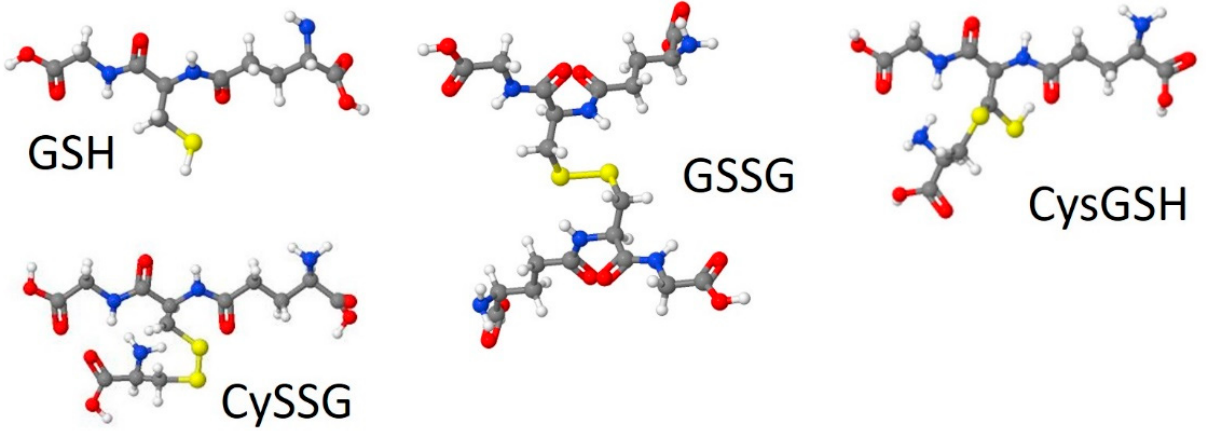
Figure 1. Structures of glutathione (GSH), L-cysteine-glutathione disulfide (CySSG), glutathione disulfide (oxidized glutathione, GSSG), and cysteinyl glutathione (CysGSH). Models were drawn by Jmol, through an interface on Wikipedia (GSSG) or at http://biomodel.uah.es/en/DIY/JSME/draw.en.htm (GSH, CySSG, and CysGSH; accessed 10 and 11 August 2021), based on CID structures 124886 for GSH, 10455148 for CySSG, 65359 for GSSG, and 3080690 for CysGSH, from Pub-Chem (URL: https://pubchem.ncbi.nlm.nih.gov, accessed 22 August 2021). Plasma GSH and CySSG are usually in the 1–10 µ M range (e.g., Figure 2, derived from data in Walmsley et al. [15]), while GSSG is often 1 µ M or less [10,15]. Many studies have used enzymatic methods to measure GSH; “oxidized glutathione” is often also measured after reduction of oxidized forms to GSH; however, this method does not distinguish between the two oxidized forms of glutathione. Measurement of both oxidized forms of glutathione requires HPLC, which can distinguish between CySSG and GSSG. In healthy people over a broad age range, plasma levels of GSH and CySSG are correlated (Pearson correlation coefficient = 0.622, p < 0.001 [10]). Plasma redox pairs have different Eh values (GSH/GSSG, − 140 mV; Cys/CySS, − 72 mV; and Cys-GSH/CySSG, − 110 mV; [10]), indicating that relative concentrations of the reactants have different chemical potentials and are not at redox equilibrium in circulation. CySSG is also found in non-mammalian species, most notably in the polychaete Nereis succinea where it functions as a spawning pheromone